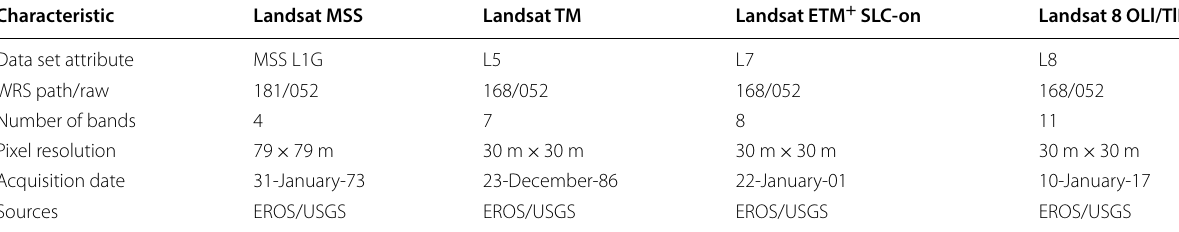
TM thematic mapper, ETM + enhanced thematic mapper plus, OLI operational land imager, TIRS thermal infrared sensor